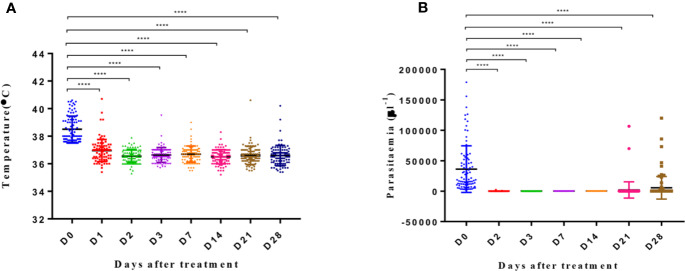
Body temperature and parasitemia across days after treatment. Y axis represents the temperature (A) and parasitemia (B) in patients. The significance levels are shown as significant (****: p < 0.0001) and nonsignificant (NS). All data were analyzed with one-way ANOVA and multiple comparisons. Error bars show the standard error of the mean (SEM).